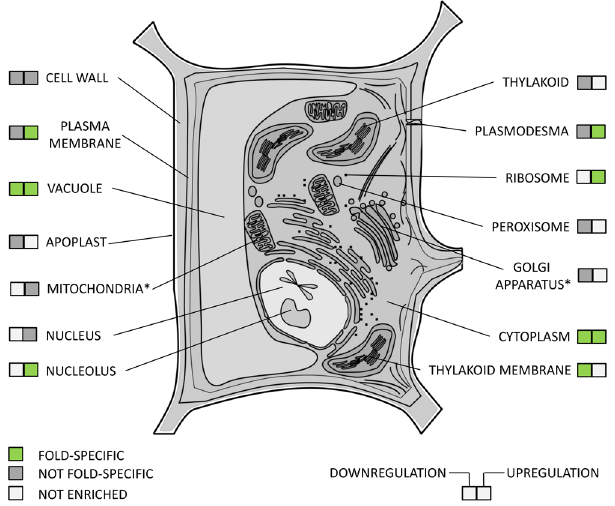
Figure 3. Cellular components differentially and fold-change-specifically regulated by auxin in the root. The source data are depicted in Supplementary Fig. 2 and Supplementary Table 4. * Golgi apparatus and mitochondria were included into the scheme since their biogenesis was auxin-regulated (Fig.